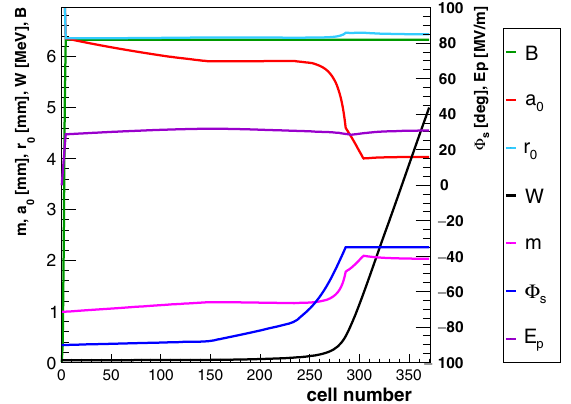
FIG. 21. Cell parameters for conceptual RFQ design of the 5-MeV deuteron accelerator proposed in this paper.